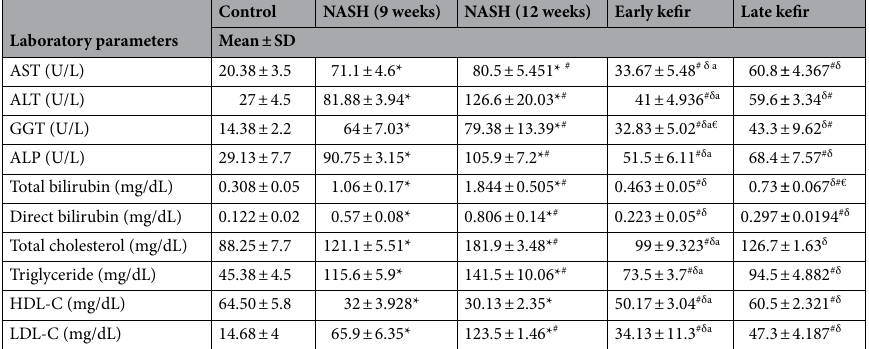
Table 3. The effect of Kefir treatment on liver function and lipid profile. Values are mean ± SD; number of animals = 8 rats/each group. One-Way ANOVA test followed by Tukey’s multiple comparison test. LDL-C low-density lipoproteins, HDL-C high-density lipoprotein, AST Aspartate aminotransferase, ALT Alanine aminotransferase, ALP Alkaline phosphatase, GGT Gamma-glutamyl transferase. *P < 0.001 compared to control group. # P < 0.001 compared to NASH (9 weeks) group. δ P < 0.001 compared to NASH (12 weeks) group. a P < 0.001 compared to Late Kefir. € P < 0.05 compared to control